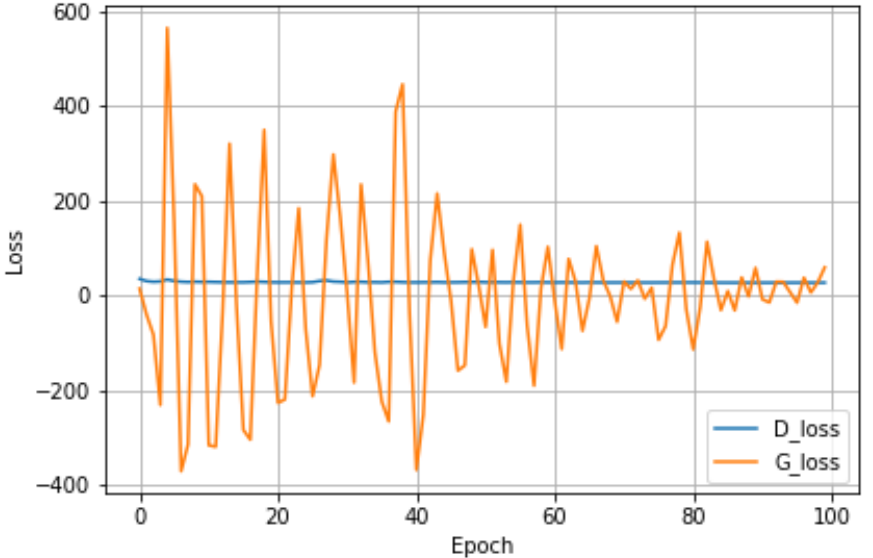
Figure 9. The discriminator and generator losses with a total of 100 epochs during the training process (blue: discriminator loss. Orange: generator loss).